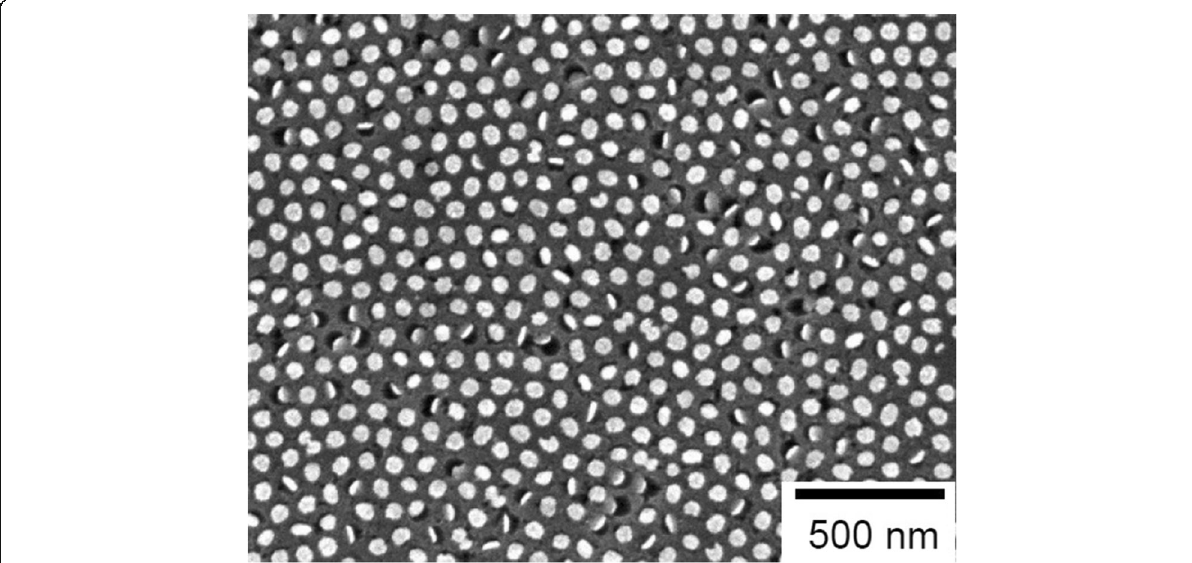
Fig. 3 SEM image of top surface of GaAs substrate after Au-assisted chemical etching in solution containing 0.001 mol dm − 3 KMnO 4 and 20 mol dm − 3 HF for 600 s at 45